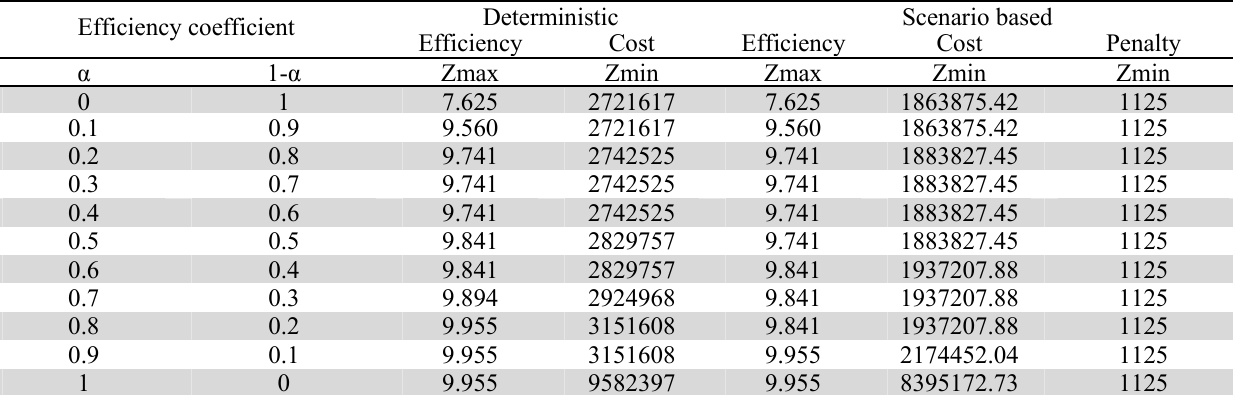
The summary of the robust optimization under different